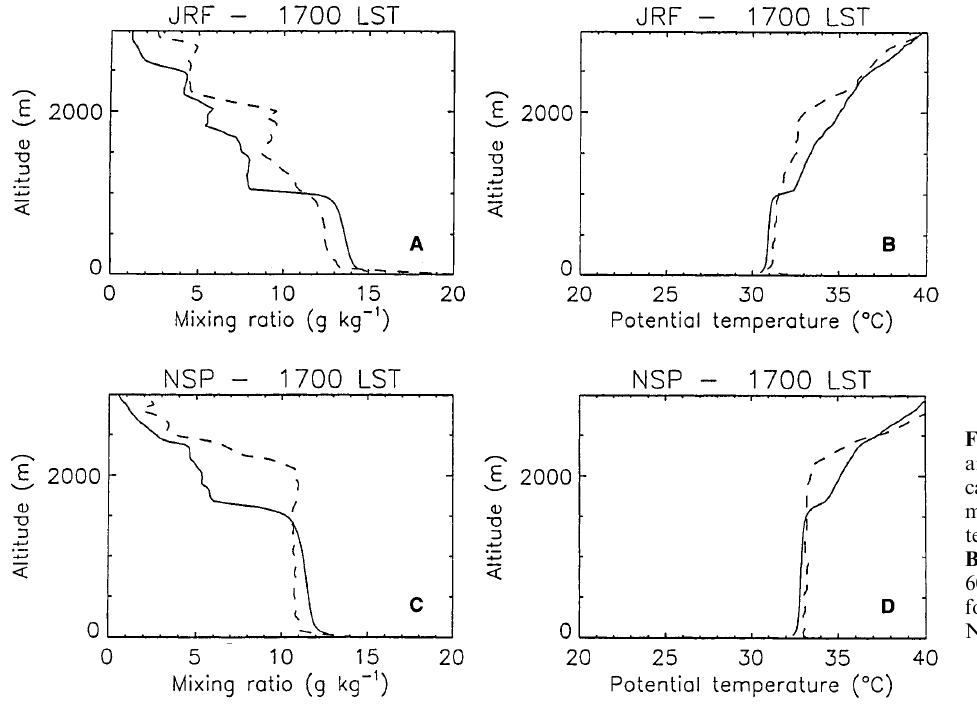
Fig. 6A–D. Simulated ( solid line ) and observed ( dashed line ) verti- cal profiles of A, C humidity mixing ratio, and B, D potential temperature at 1700 LST, over A, B undisturbed forest and C, D 60% deforested sites of Rondonia for August 18, 1994 from